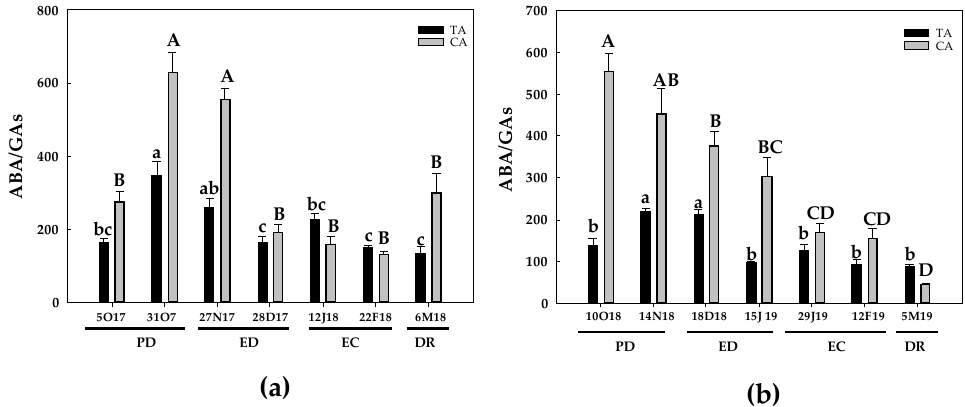
Figure 19. Evolution of abscisic acid/total gibberellins (ABA/total GAs) in flower buds of peach ‘GEM020’ cultivated in a cold area during the dormancy cycle on two seasons. ( a ): season 1 (2017– 2018); ( b ): season 2 (2018–2019). Data represent the mean ± SE, n = 5. Different letters (lowercase and uppercase for the samples of the temperate (TA) and the cold area (CA), respectively) indicate significant differences according to Tukey’s multiple test ( p ≤ 0.05). PD: paradormancy; ED: endo- dormancy; EC: ecodormancy; DR: dormancy release. FW: fresh weight. The chill units accumulated at the different times and locations are shown in Supplemental file 1.